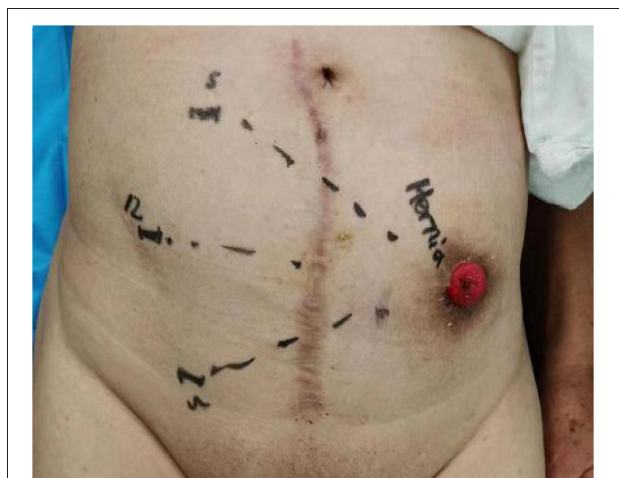
FIGURE 2 | Layout of the trocar